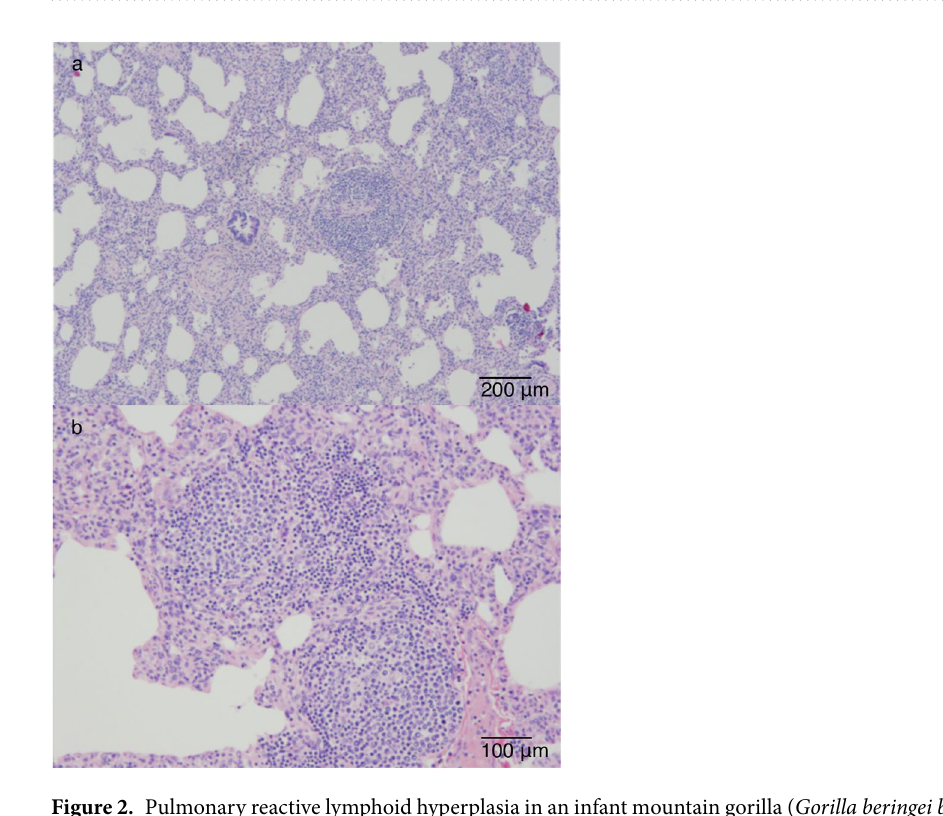
Figure 2. Pulmonary reactive lymphoid hyperplasia in an infant mountain gorilla ( Gorilla beringei beringei ). Histological lesions included lymphocytic interstitial pneumonia exemplified by diffuse infiltration of the alveolar septa by lymphocytes (a and